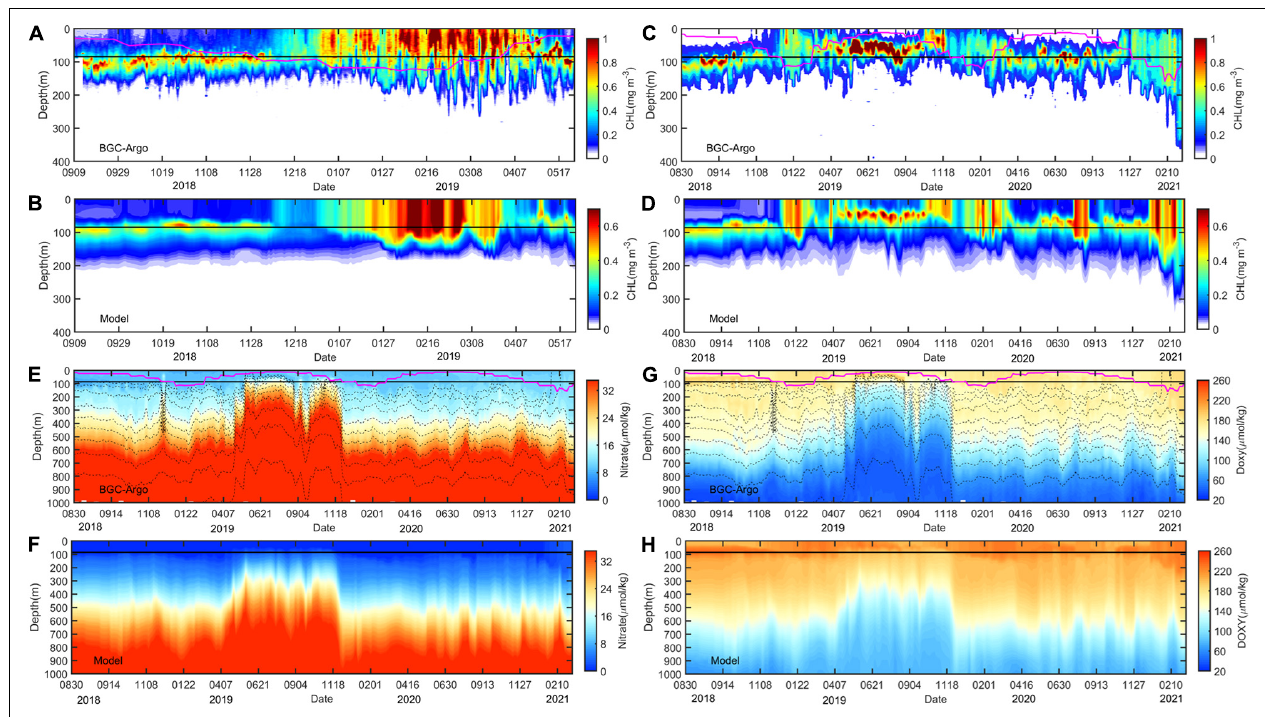
FIGURE 7 | Comparison of time series of the modeled parameter (A–D) CHL (mg m − 3 ), (E,F) NO 3 ( µ mol kg − 1 ) and (G,H) DO ( µ mol kg − 1 ) with data recorded by BGC-Argo floats in the region south of Japan from 2018 to 2021. The black dashed lines in (E,G) are potential density contours. The magenta lines indicate the MLD, and the black lines indicate the base of